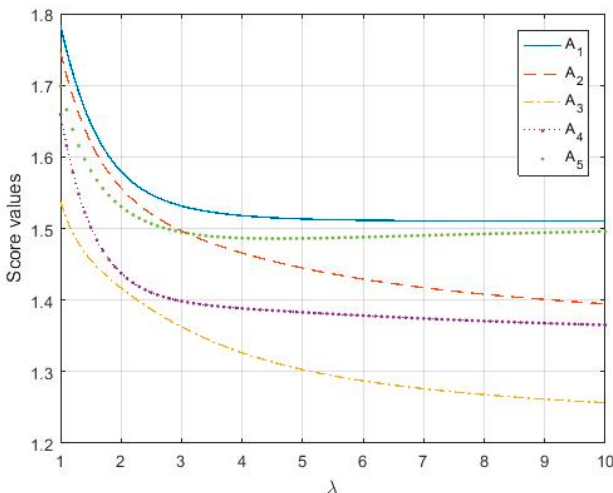
Figure 3. Score values of the alternatives when λ ∈ ( 1,10 ) based on the q -RPFDWHM operator.